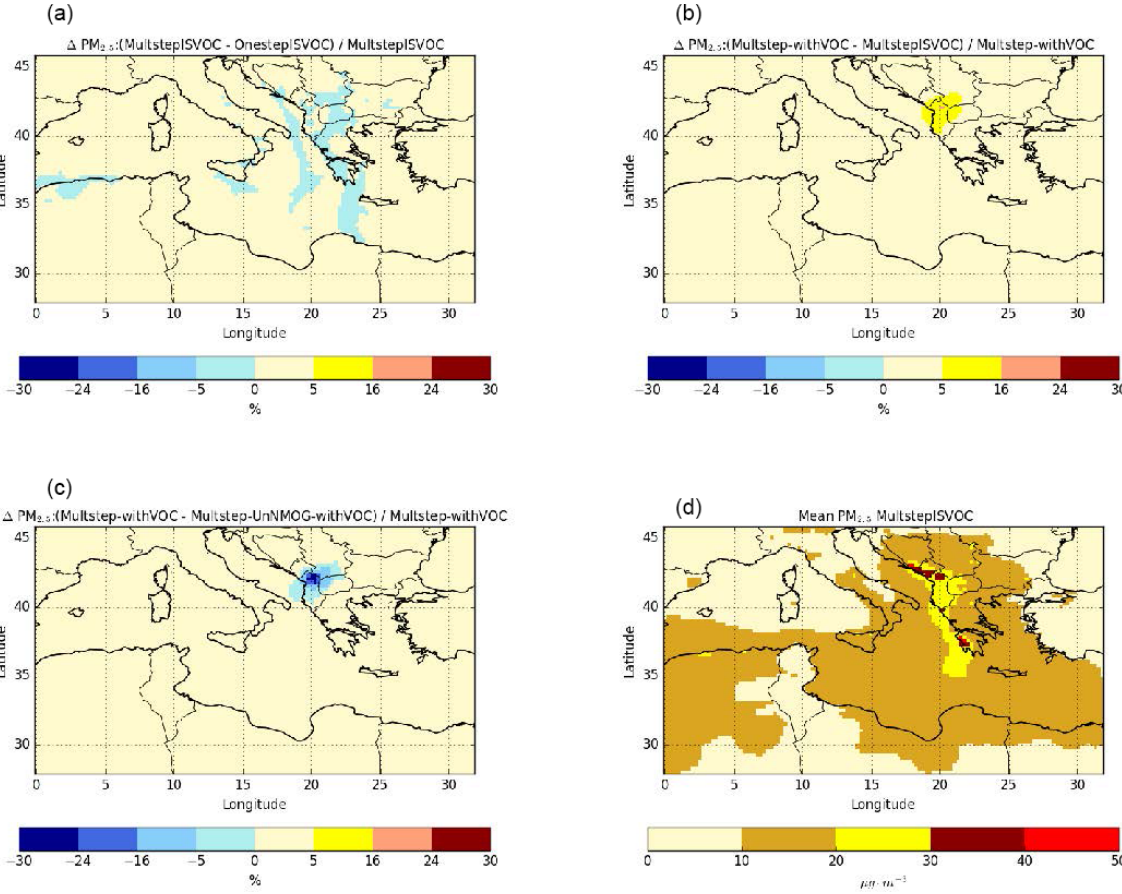
Figure 13. Sensitivity of surface PM 2 . 5 concentrations to the gaseous I/S/L-VOC ageing scheme (a) , the SOA from the selected VOC (b) , the SOA from gaseous I/S/L-VOC emissions estimated from NMOG (c) and daily mean PM 2 . 5 concentrations from the Multstep-withVOC simulation (d) during the summer of 2007 (from 30 June to 30 August 2007).